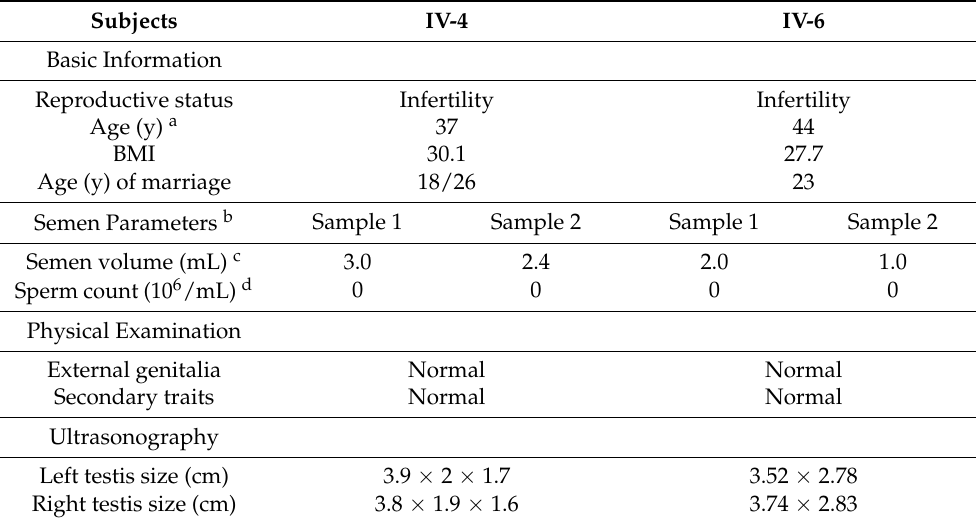
Table 1. The clinical characteristics of male individuals.